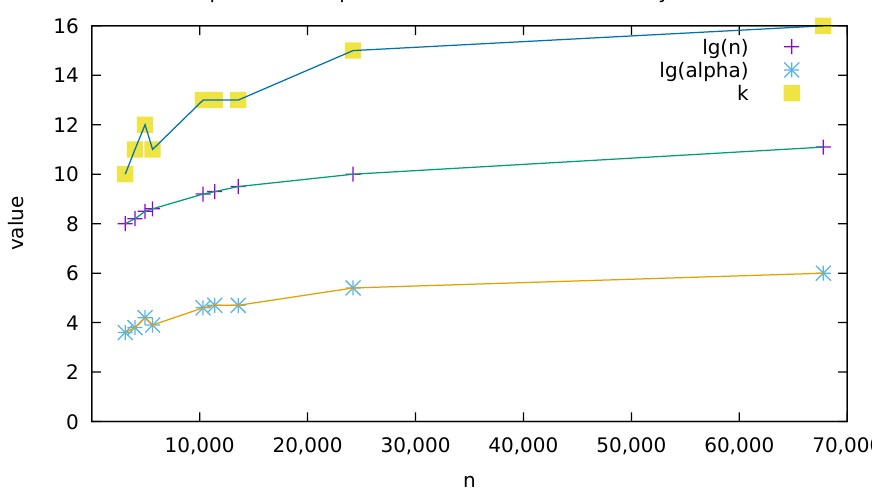
Figure 3. Plots comparing the experimental values of log n , log α and k from Table 3: log α is roughly half of log n , itself roughly half of k . This implies that the experimental values of the alternation α are only polynomially smaller than the number n of weights, and that experimental values of k are exponentially smaller than both the number n of weights and the alternation α . The consequences on preducted running times are described more explicitly in Figure 4.